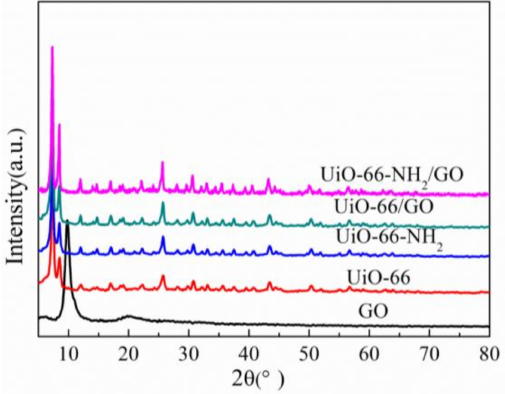
Figure 1. X-ray diffraction patterns of the different samples.